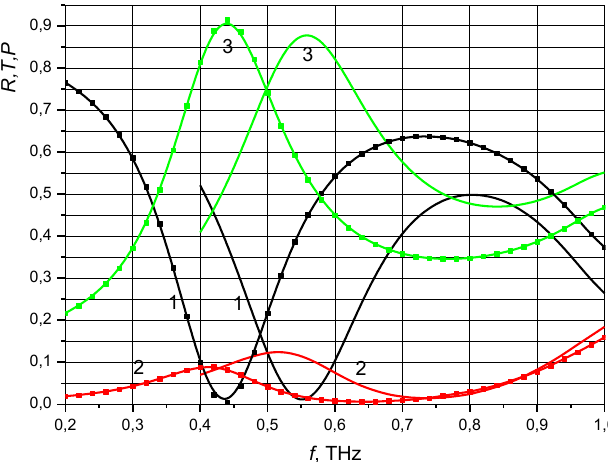
Fig. 5. Frequency dependences of the reflection, transmittance coefficients and losses in the resonance metasurfaces of single square graphene strip in the unit cell on the multilayer graphene- dielectric substrate: Curves 1 — R , 2 — T , 3 — P ; a = b = 70 μ m. Seven -layer structure h d =25 μ m, and n d = 1.77: μ с = 0.25 eV. Lines with symbols W = l = 60 μ m; lines without symbols W = l = 50 μ m. Other parameters are as in Fig.